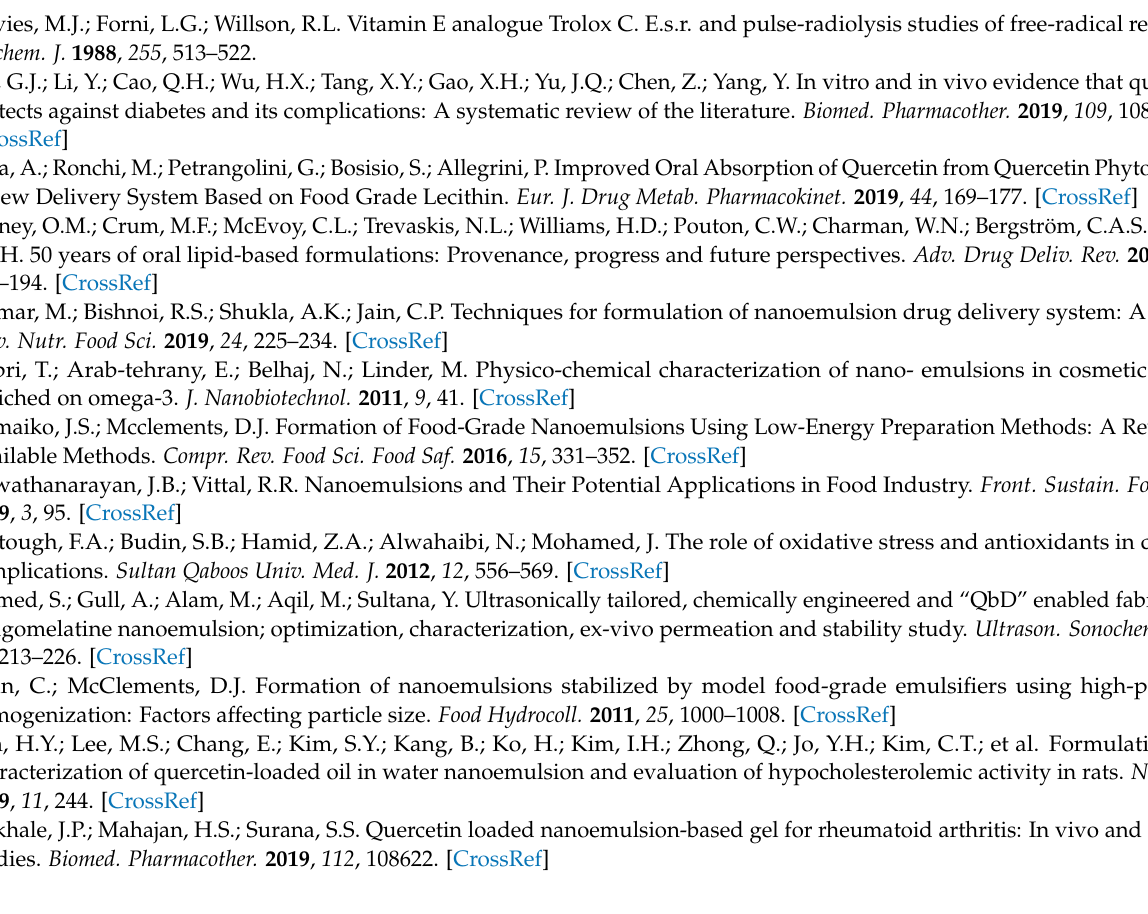
Figure S2: Desirability Plot from Box-Behnken Design for